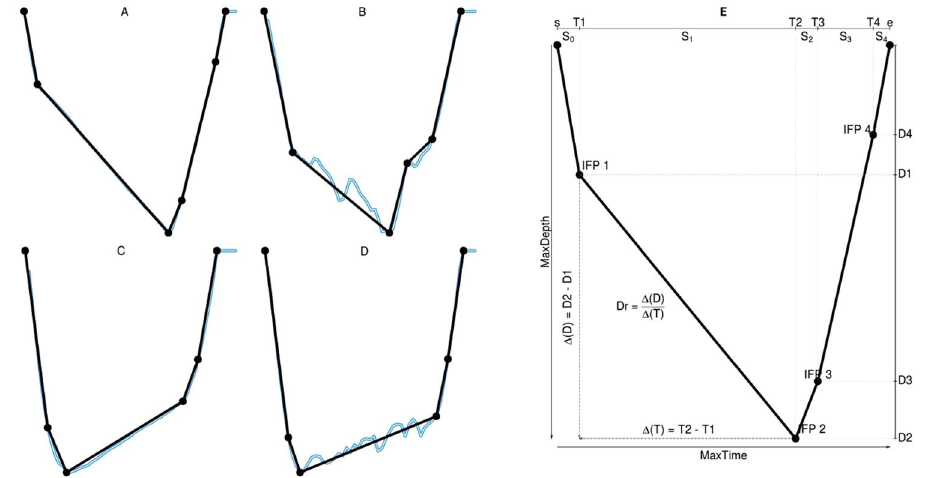
Figure 1. Explanation of drift dives. Obtained from summarized high-resolution tag data. Example of an ( A ) negative and ( C ) positive drift dive, as well as non-drift dives whose summarized forms incorrectly resemble ( B ) negative and ( D ) positive drift dives. Blue lines represent high-resolution time depth profiles, while black represents the summarized profiles from the Broken-Stick algorithm. ( E ) Diagram of a summarized drift dive including the main criteria used to classify summarized profiles as drift dives. For this dive, the ifp (inflection point order) is 2.1.3.4. Summarized inflection points are IFP1{T1, D1}, IFP2 {T2, D2}, IFP3 {T3, D3} and IFP4 {T4, D4}. ps0 represents the proportion of the dive duration spent on the descending phase (T1/MaxTime etc.). S 1 the proportion spent along the first BSA segment (T2 − T1/E), S 2 along the second segment (T3 − T2/E), S3 for the third segment (T4 − T3/E) and S4 between the last ifp and the end of the dive (e − T4/E). Drift rate (Dr) is calculated as the difference in depth divided by the difference in time over the drifting segment (in this case, the segment between IFP1 and